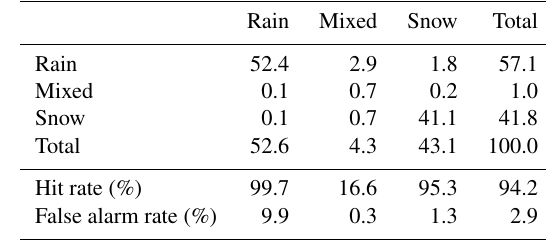
Table 5. Comparison of the precipitation phase detected by the Thies disdrometer (rows) and the two-dimensional video disdrom- eter (columns). The numbers are given as percentages of the to- tal number of 1min observations during 2 years of measurements, which are equal to 2533h of